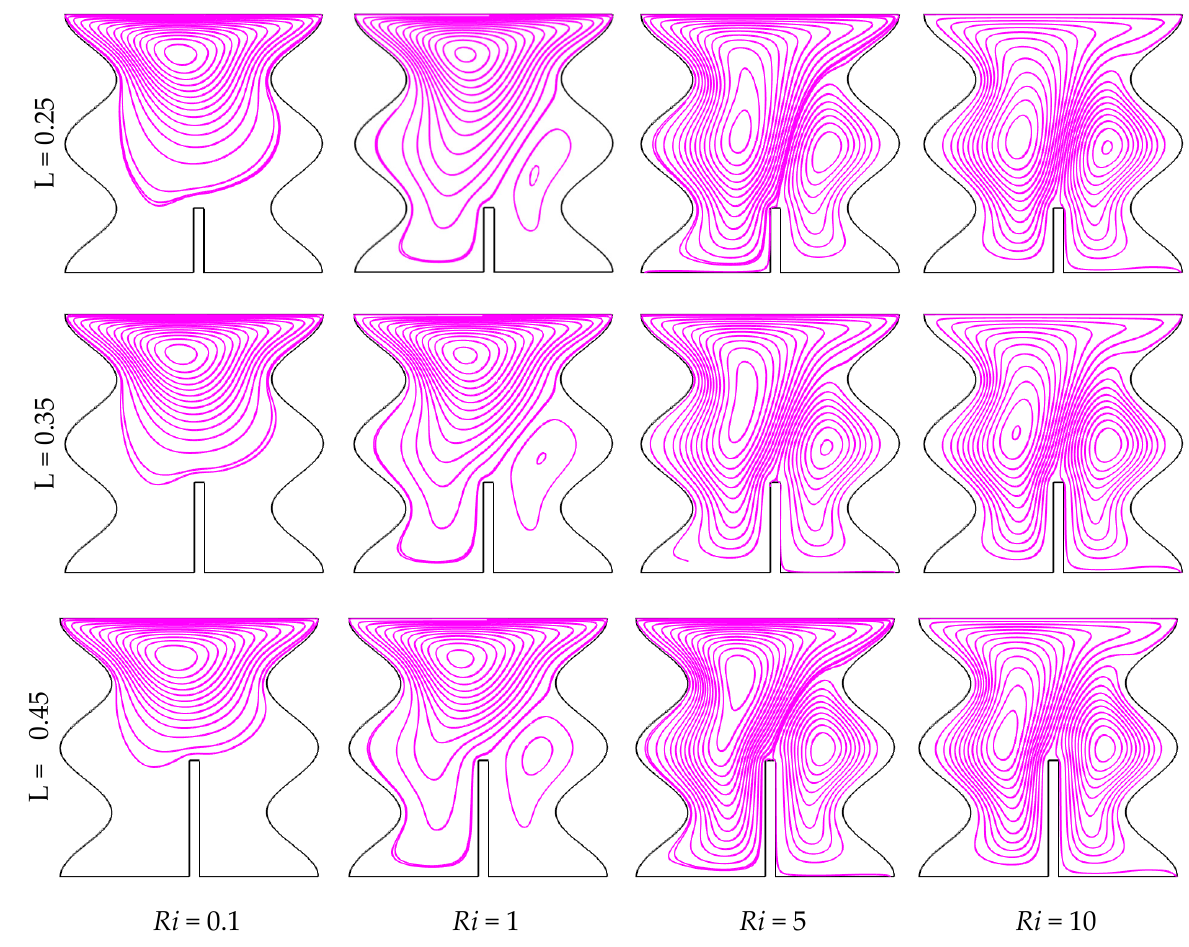
Figure 4. Streamlines for various Ri and L at Ha = 10, and λ = 2.